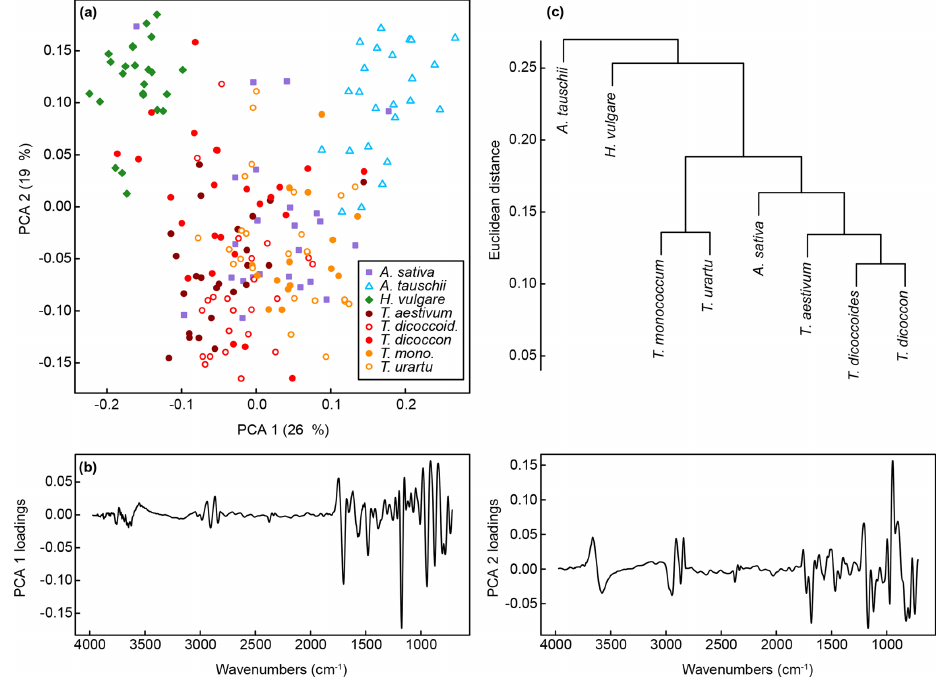
Figure 6. (a) PCA of FTIR spectra processed with Savitzky–Golay smoothing and first derivatives. Values in parentheses show the percentage variance explained by each PCA axis. “ T. dicoccoid .” represents T. dicoccoides ; “ T. mono .” represents T. monococcum . See Fig. S2 for PCA axes three to six. (b) Loadings for PCA axes one and two. (c) Cluster analysis of FTIR spectra processed with Savitzky–Golay smoothing and first derivatives based on the mean spectrum for each